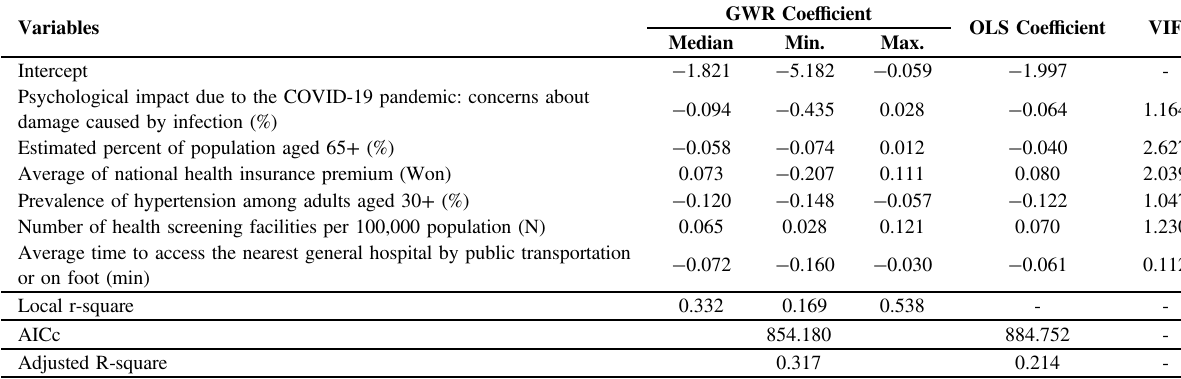
Table 4 Summary of coe ffi cient of GWR and OLS